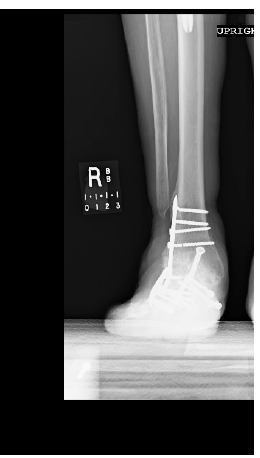
Figure A5. 5 years post-op with additional fractures in a 3.5 mm cortical screw in the tibia, a second 3.5 mm talonavicular screw, the 6.5 mm cannulated screw, and the 3.5 mm LCP plate.